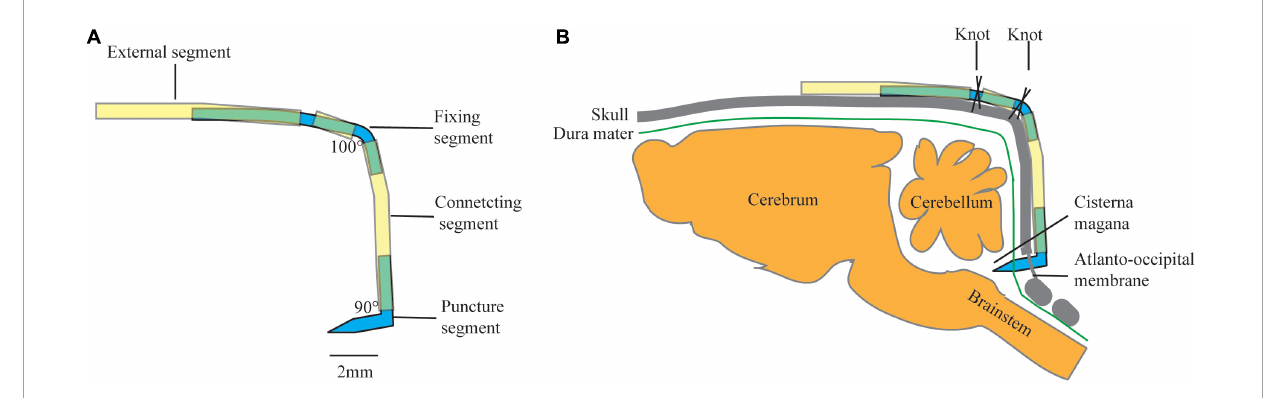
FIGURE1 Schematic of cannulation design: (A) diagram of a constructed cannula, and (B) schematic drawing of annulation placement in rat. Yellow tube: polyethylene (PE) tube (PE50), Blue tube: modified 18 G syringe needle.